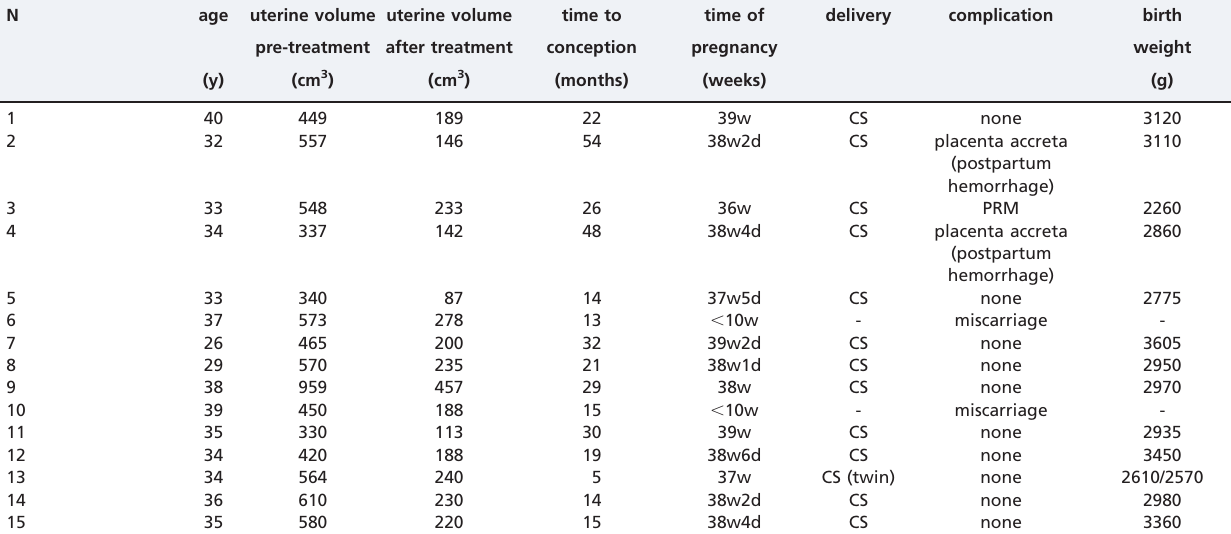
Table 1 - Pregnancy characteristics. N age uterine volume uterine volume time to pre-treatment after